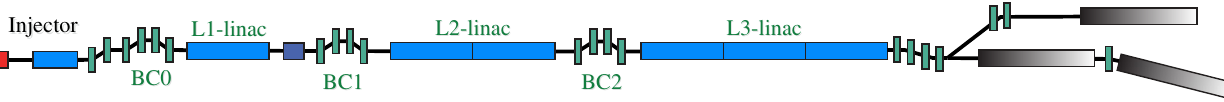
FIG. 1. A layout of the European XFEL is shown. The electron pulse enters on the left end, is accelerated to high energy and then used to create light at the right end at any one of three undulators. The laser ’ s output energy per bunch is measured after each undulator at the end of the